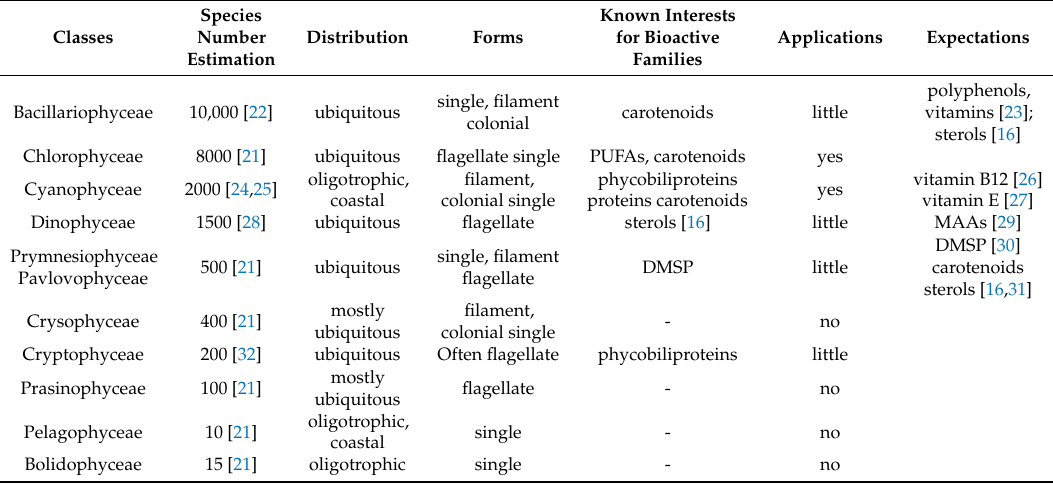
Table 1. Principal marine microalgal classes (ca. 50,000 known species, estimated to be 200,000–800,000 species [21]; microalgal biomass represents ca. one-quarter of the total vegetation biomass in the world) and their potential in antioxidant